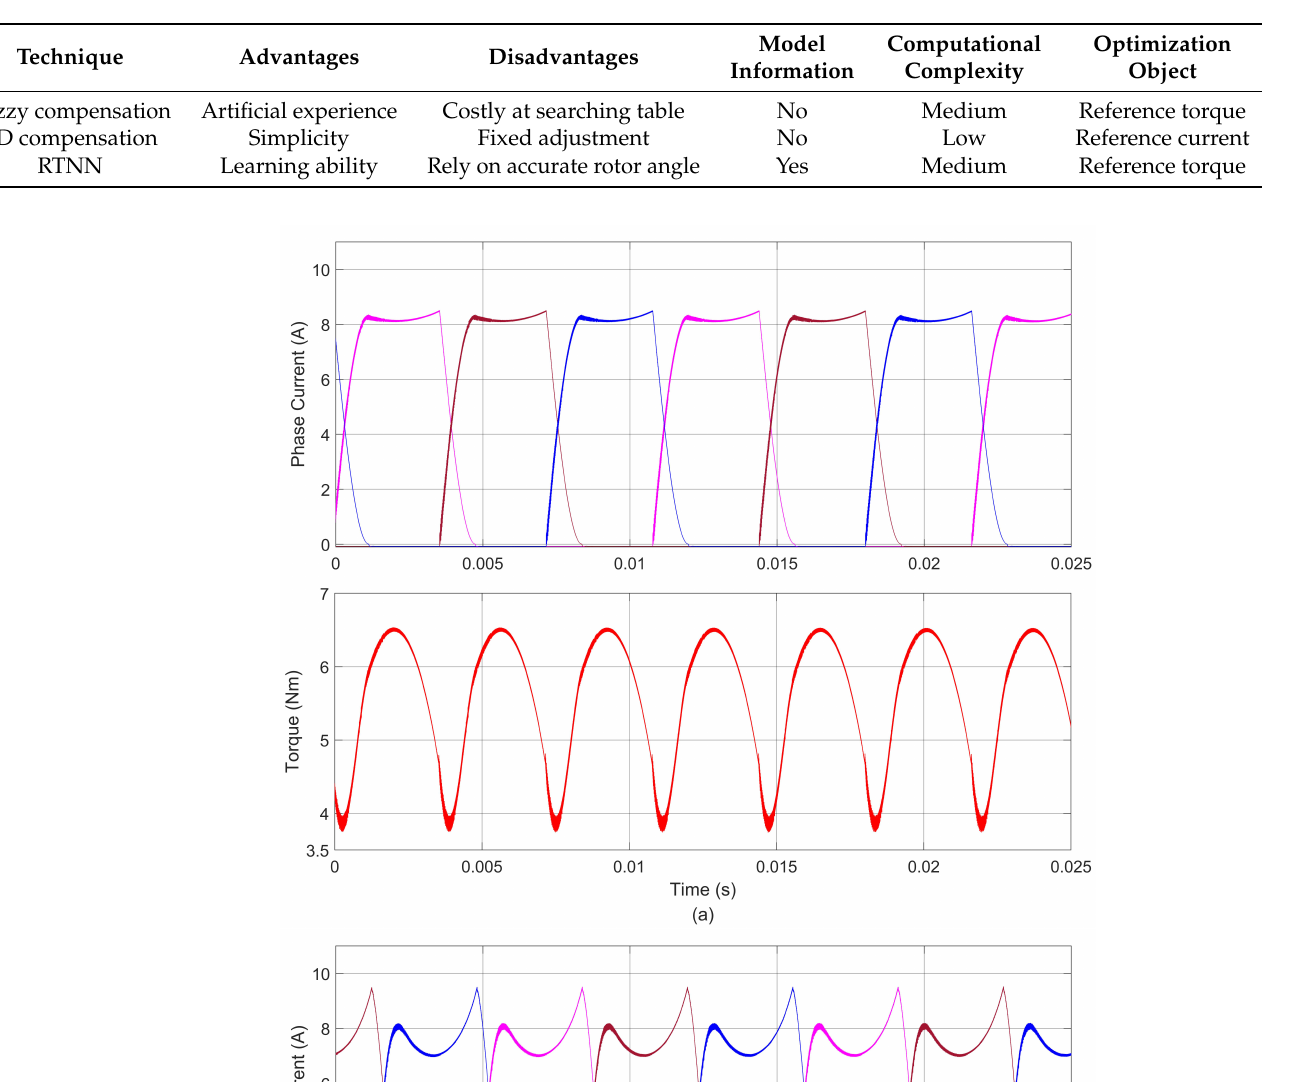
Table 2. Performance comparison of the three methods.